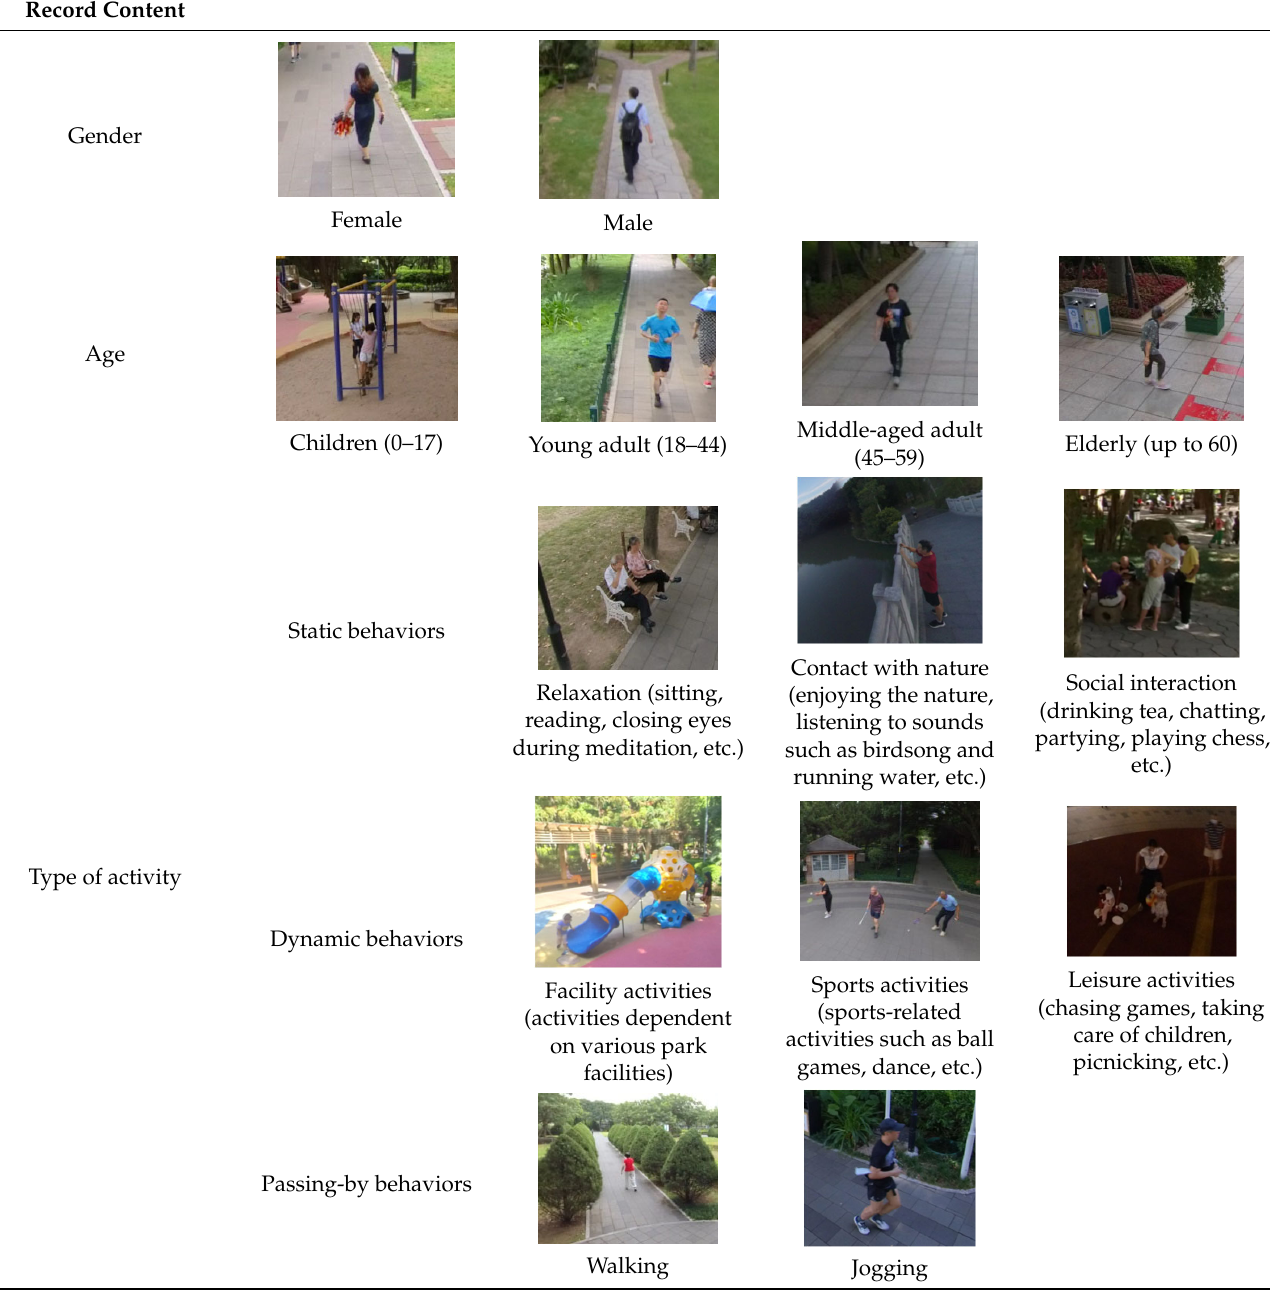
Table 1. SOPARC record content.